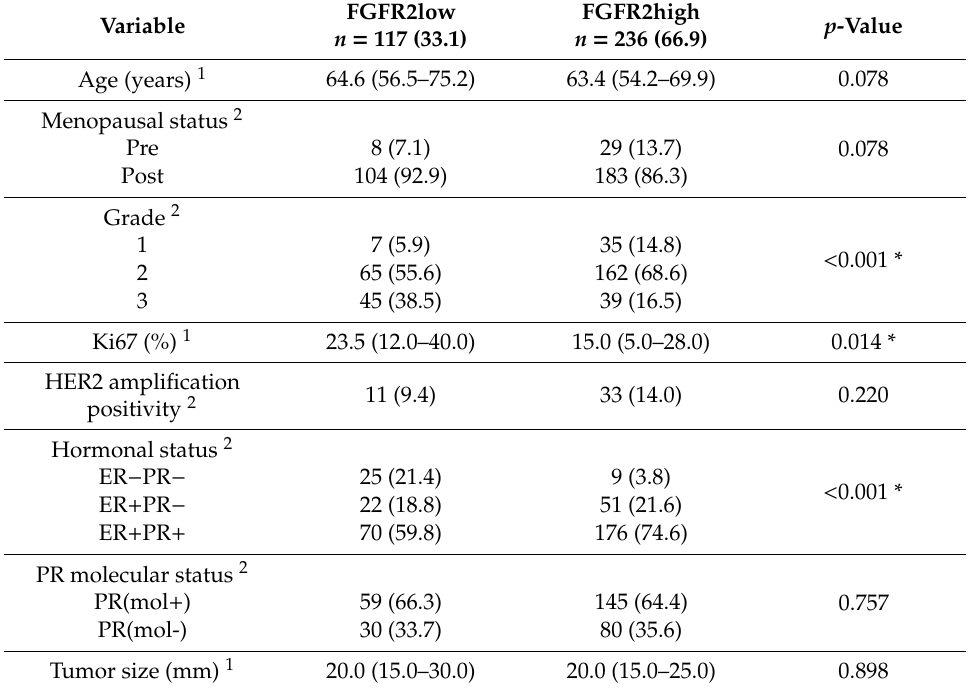
Table 2. Clinicopathological features in fibroblast growth factor receptor 2 (FGFR2)low